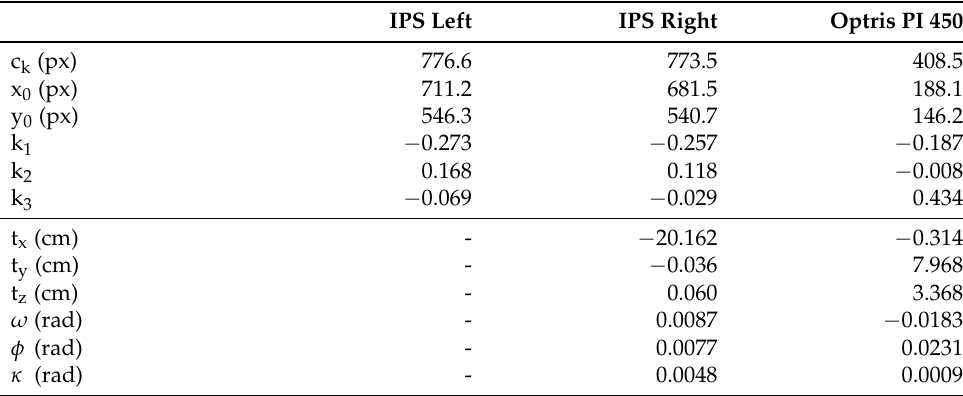
Figure 3. Epipolar lines at a selected point (color bar with temperature values). Table 2. Calibration results for the trifocal